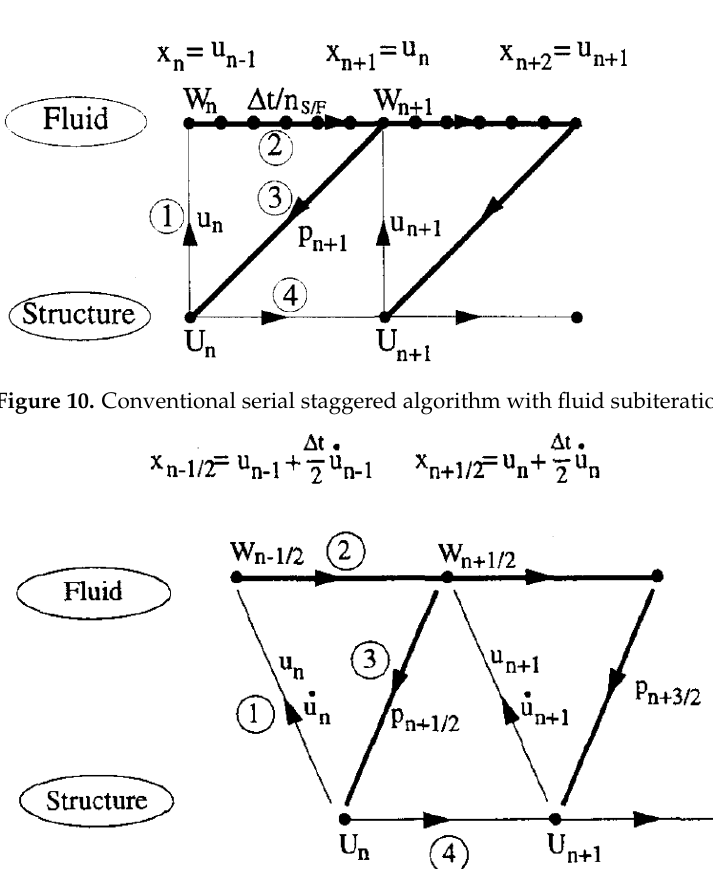
Figure 11. Improved serial staggered